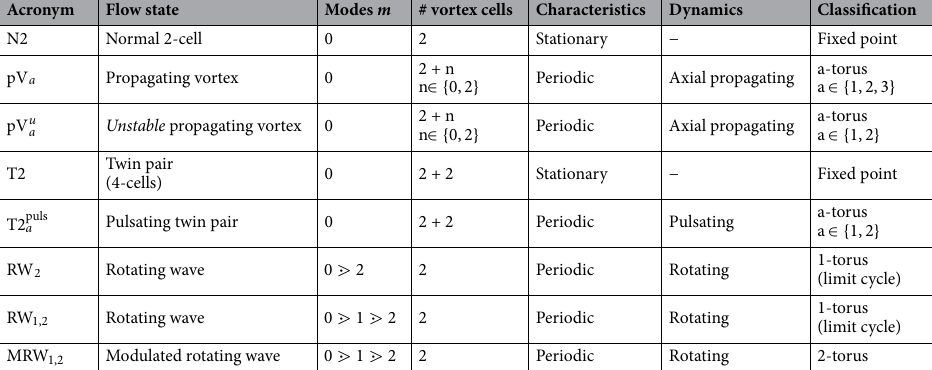
Table 1. Flow state nomenclature and abbreviations. From left to right; acronym, flow state, dominant azimuthal (mode) contribution, numbers (#) of vortex cells, flow characteristics, flow dynamics and classification (see also Fig. 3). The relation, ⋗ , indicates that corresponding stimulated (azimuthal) mode amplitudes are larger or smaller. Note all rotating structures exist as symmetry degenerated with either dominant positive ( m ) or negative (